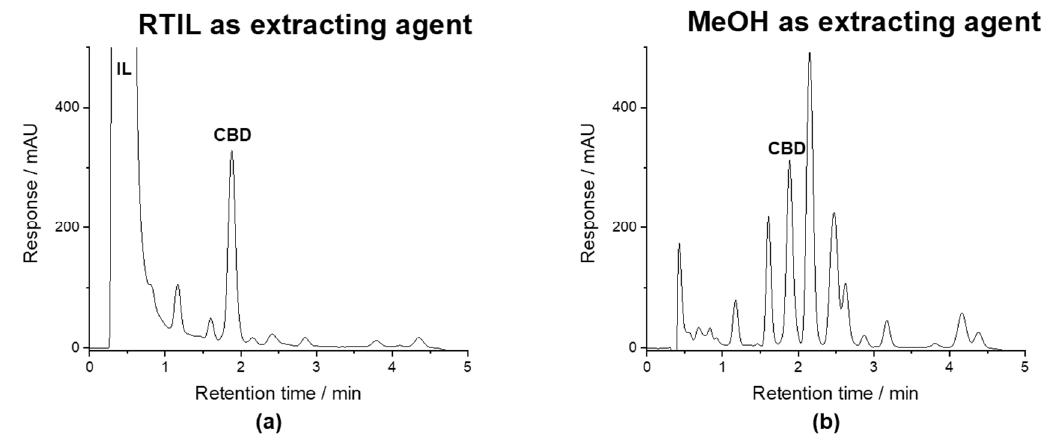
Figure2. Roomtemperatureionicliquid(RTIL)asextractingagent( a )incomparisontoamicroextraction Figure 2. Room temperature ionic liquid (RTIL) as extracting agent ( a ) in comparison to a with pure MeOH ( b ) for the isolation of cannabidiol (CBD). microextraction with pure MeOH ( b ) for the isolation of cannabidiol (CBD). Table 2. Validation parameters for the linear model.